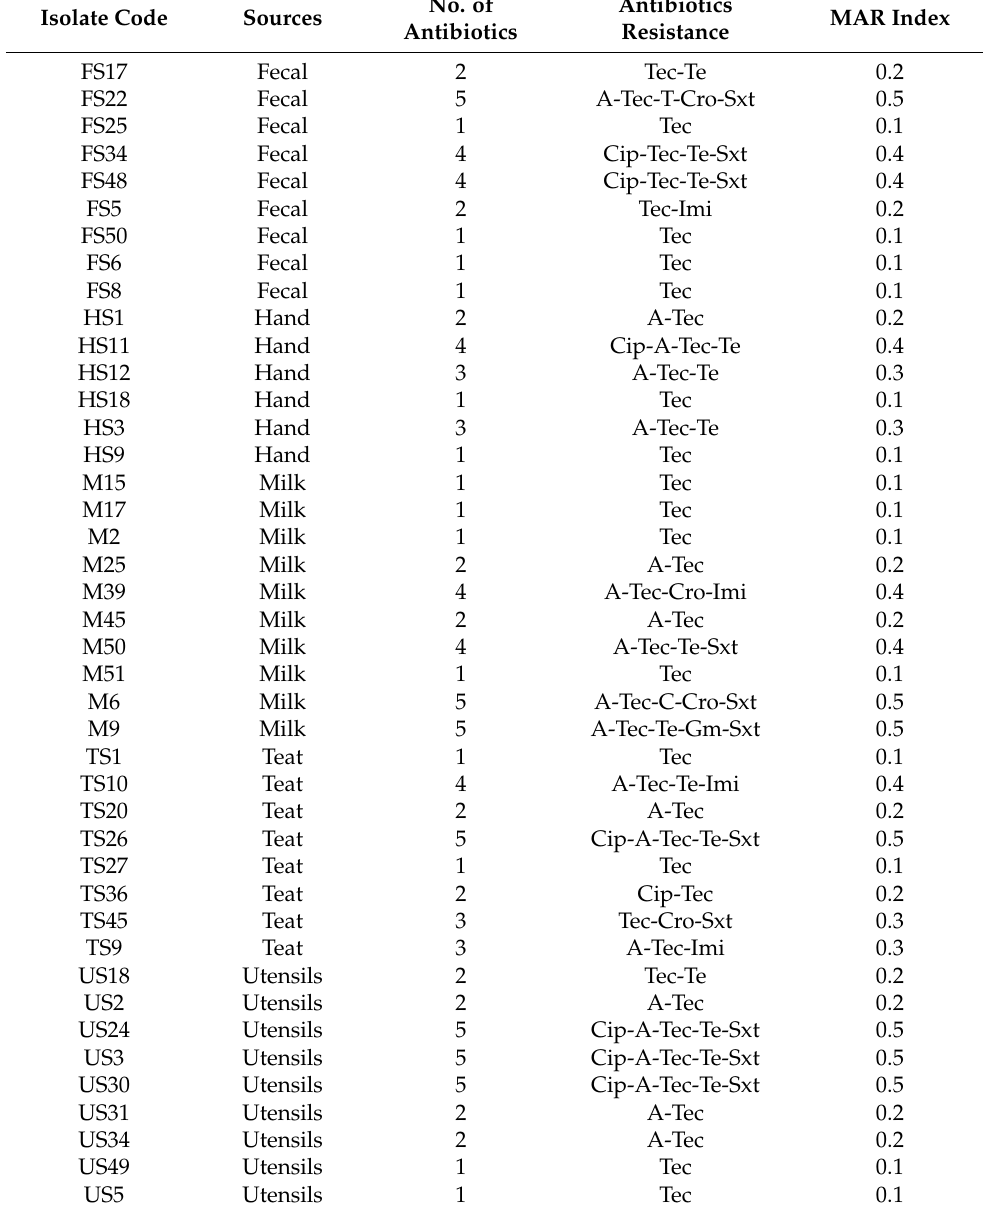
Table 3. Antibiotic Resistance Profile and Multiple Antibiotic Resistant Index of Individual E. coli